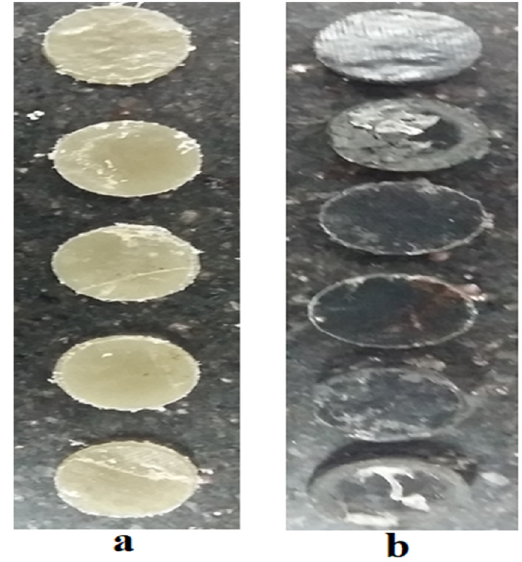
Figure 10: ( a – b ) : CRT testing